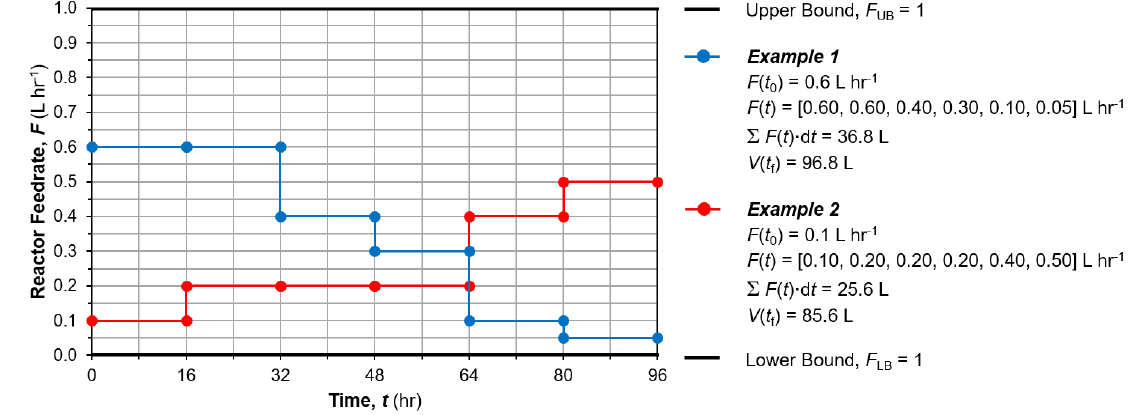
Figure 5. Sample dynamic simulation reactor feedrate profiles.